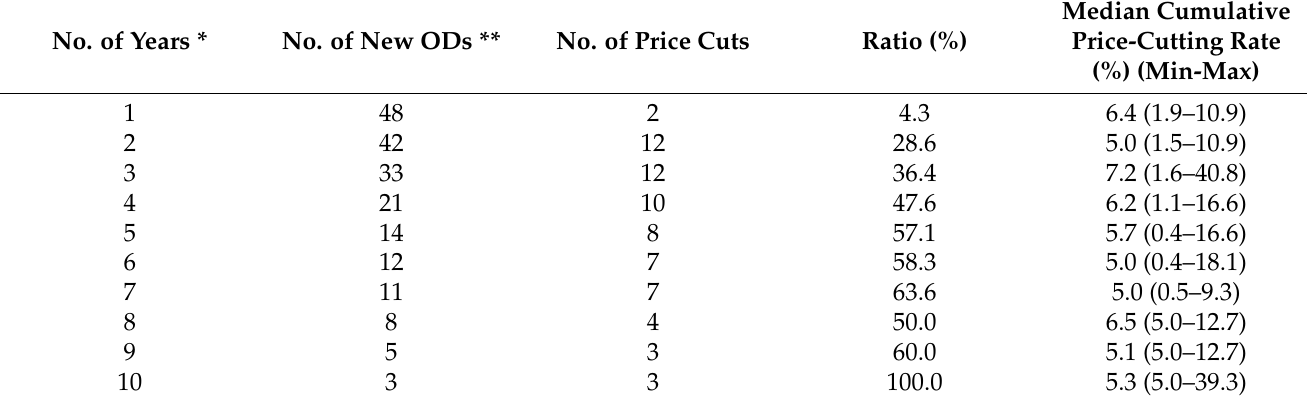
Table 6. Cumulative price-cutting rate of new orphan drugs after listing by year.